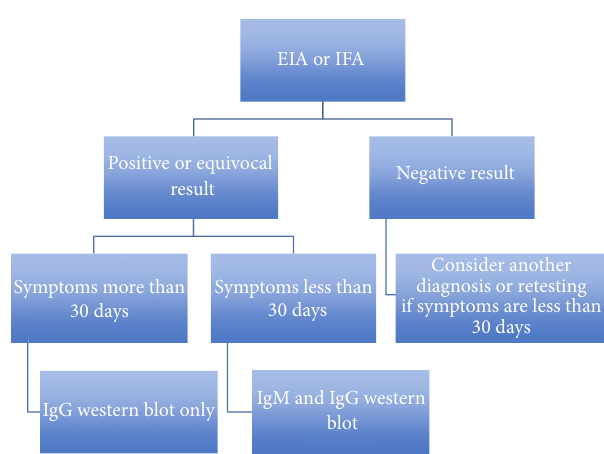
Figure 3: A step-wise approach for the diagnosis of Borrelia infection in a patient with clinically suspected Lyme